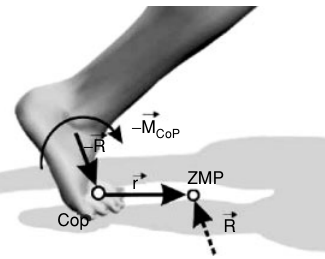
Figure 1 ZMP and CoP (Vukobratovi´c et al. 2001).